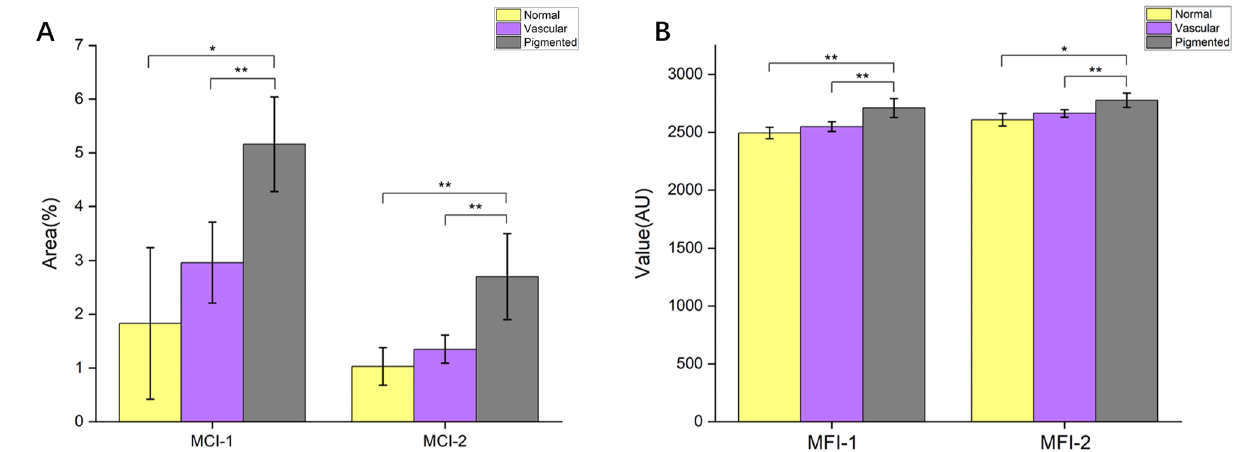
Figure 6. MCIs and MFIs of different groups in pump-probe imaging. ( A ) MCI of different groups. ( B ) MFI of different groups. (*P < 0.05; **P <